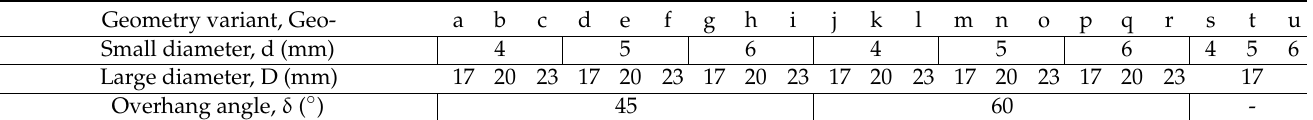
Figure 3. Methodology for local evaluation of geometry effect on tensile strength at evaluation point Q, ( a ) LPBF-made geometry with variation of D, d, δ for Geo-a–Geo-r and D, d for Geo-s–Geo-u ( b ) Uniform tensile test geometry after machining, ( c ) Isometric view of sample designs in LPBF-made condition and after machining in tensile test geometry. Table 1. Geometry variants of tensile test samples.